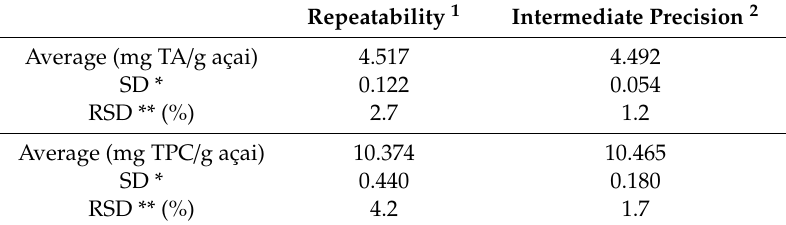
Table 3. Results obtained from the precision study for TA and TPC.